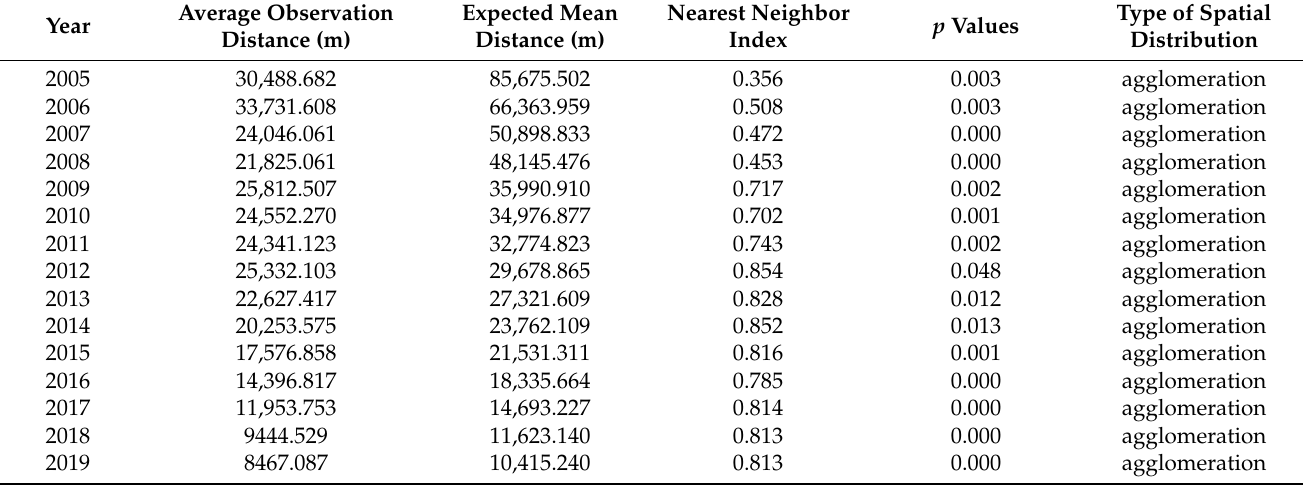
Table 1. The nearest neighbor index of the average spatial distribution of A-level scenic spots in Guizhou Province. Average Year